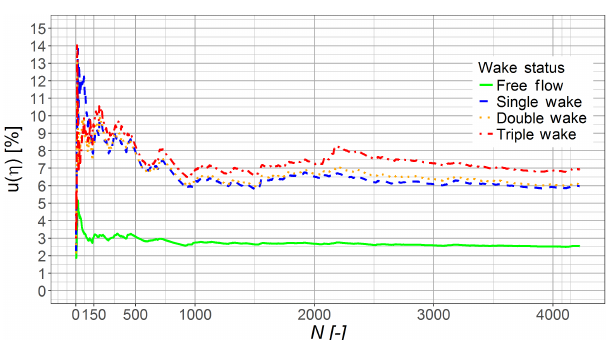
Figure 12. Uncertainties for the underperformance indicator u ( η ) as a function of N values for free-flow, single-wake, double-wake and triple-wake situations. Uncertainties for free-flow conditions (green) are much lower than the uncertainties for the waked tur-